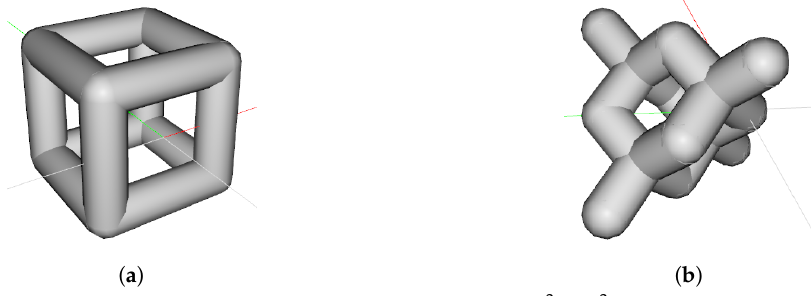
Figure 3. ( a ) Cubic cell; ( b ) diamond cubic cell of lattice size = (1.5) 3 mm 3 and lattice thickness = 0.5 mm.